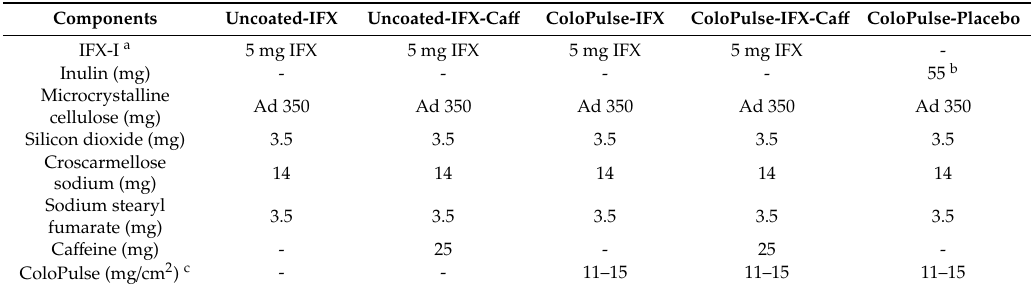
Table 2. The components of the di ff erent formulations. Abbreviation: IFX-I: Infliximab reconstituted with the inulin solution and thereafter